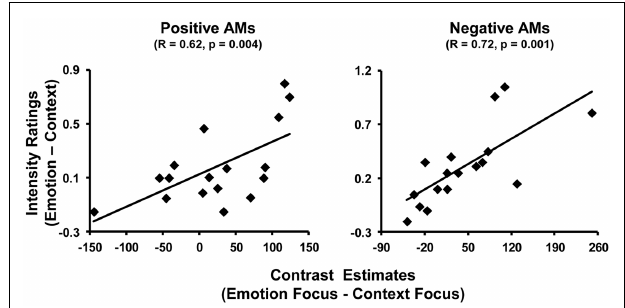
FIGURE 4 | Positive correlation between activity in theAMY and self-reported emotional ratings . Differential activity in the AMY for Emotion and Context focuses was positively related to the difference in emotion intensity ratings between Emotion and Context conditions during recollection of positive (left panel) and negative (right panel) memories.The scatter plots are based on contrast estimates for Emotion – Context conditions extracted from the peak voxel of the areas showing the co-variation with the differences in ratings, in the left AMY. Similar co-variations were also identified in right AMY (not shown).